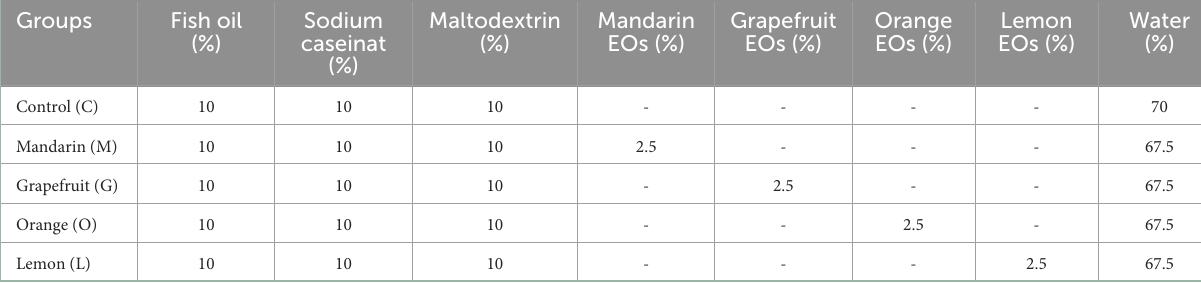
TABLE 1 Composition and proportions of emulsions.